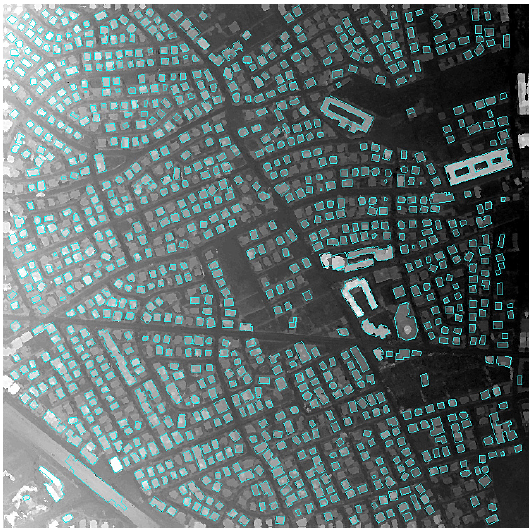
Figure 8: Building outline approximation (green polygons)